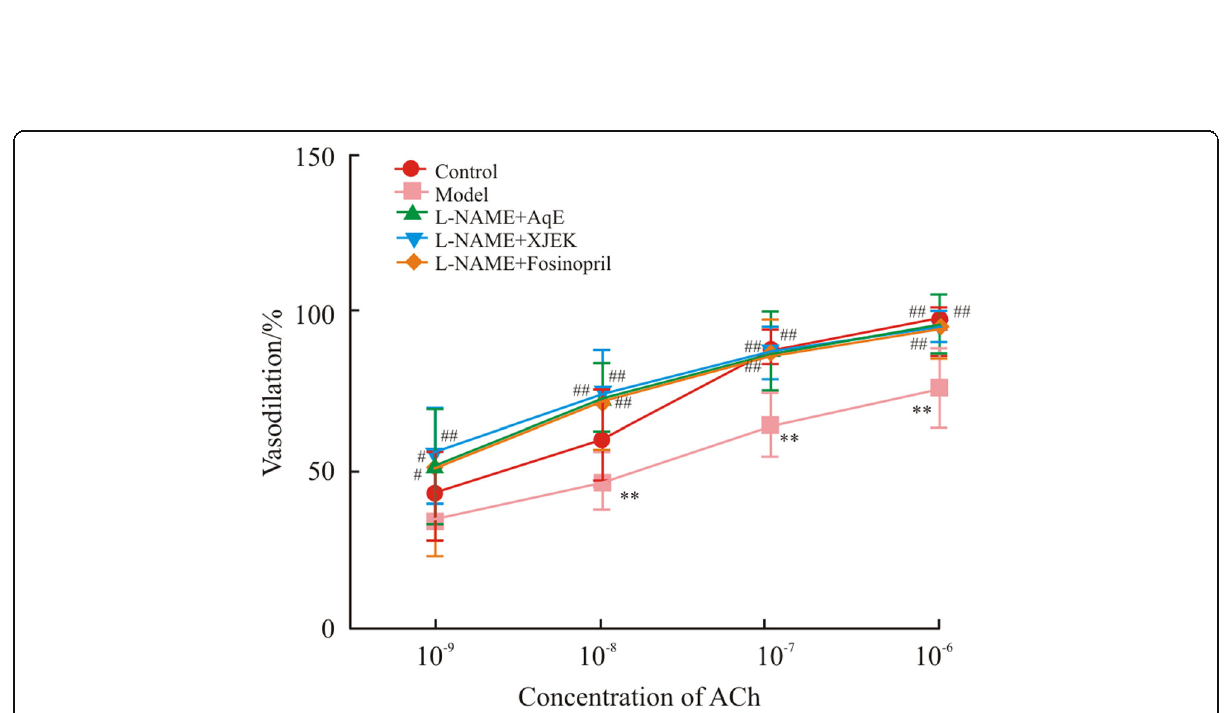
Fig. 7 Effects of polysaccharide extract from XJEK on ACh-induced endothelium dependent relaxation. In a phenylephrine pre-contracted isolated mouse aortic ring preparation, administration of ACh induced notable endothelium-dependent relaxation in a dose-dependent manner, which was markedly lower in aorta isolated from L -NAME-induced hypertensive mice. A significant restoration of ACh-induced endothelium-dependent relaxation was observed in aorta isolated from polysaccharide-treated hypertensive mice. Data are presented as the mean ± SD ( n = 10). ** P < 0.01 vs. control group; # P < 0.05, ## P < 0.01 vs. model group